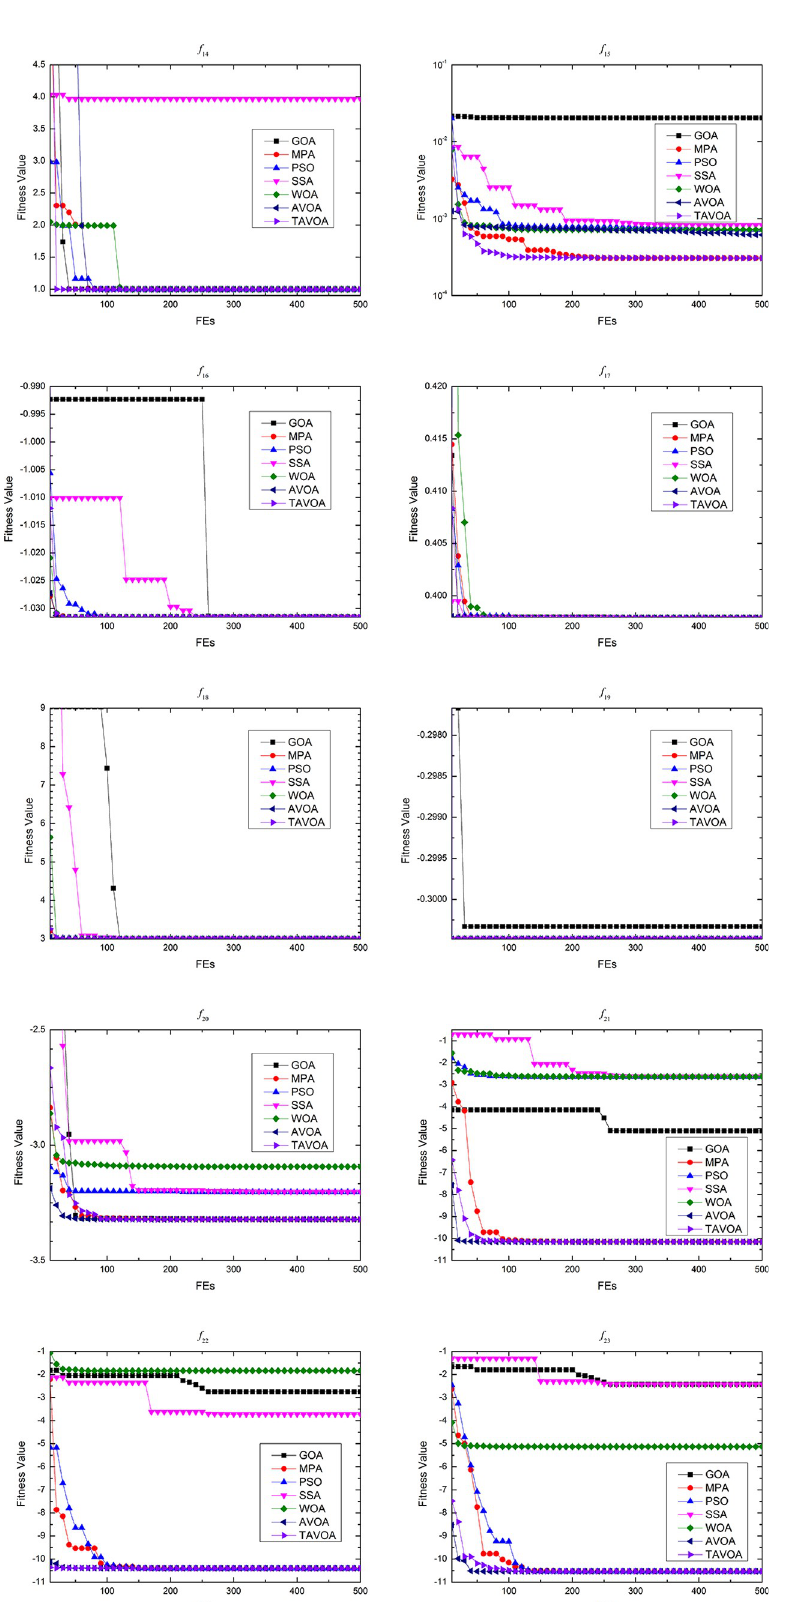
Fig 9. Convergence process on basic fixed-dimension multi-modal benchmark functions. https://doi.org/10.1371/journal.pone.0260725.g009 PLOS ONE | https://doi.org/10.1371/journal.pone.0260725 November30,